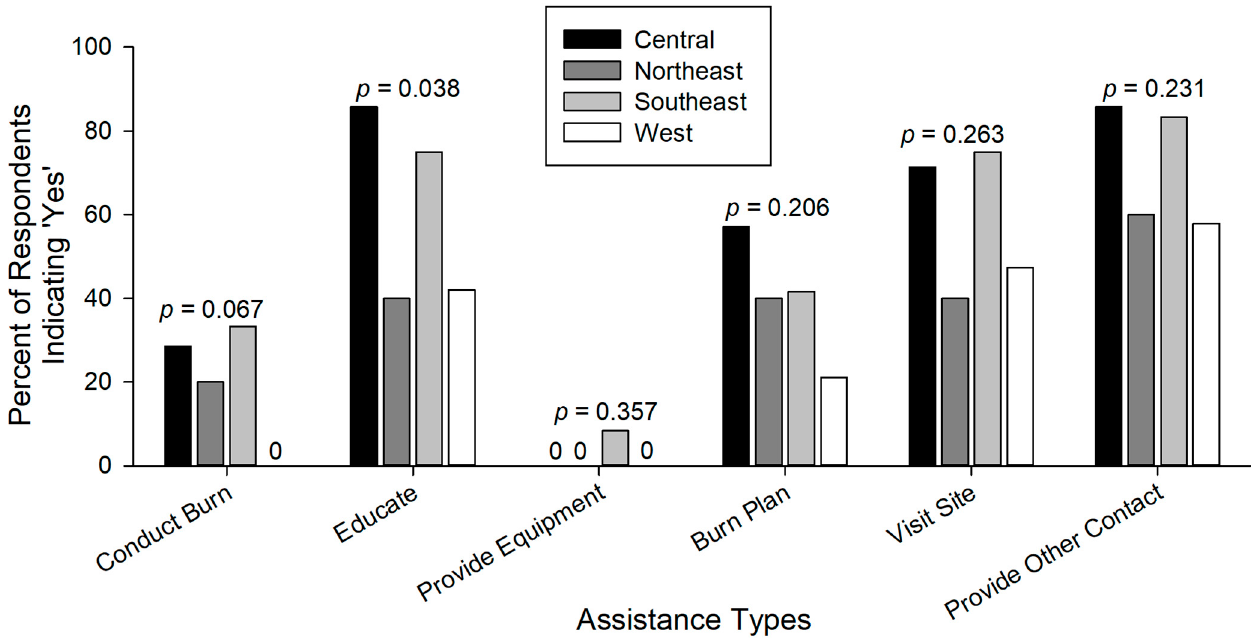
Figure 3. Different types of assistance that survey respondents ( n = 50) have provided private landowners with when planning a prescribed fire, stratified by region and presented as the percentage of respondents responding that they do provide this assistance. Chi-square test p -values for regional effects are presented above each Assistant Type.